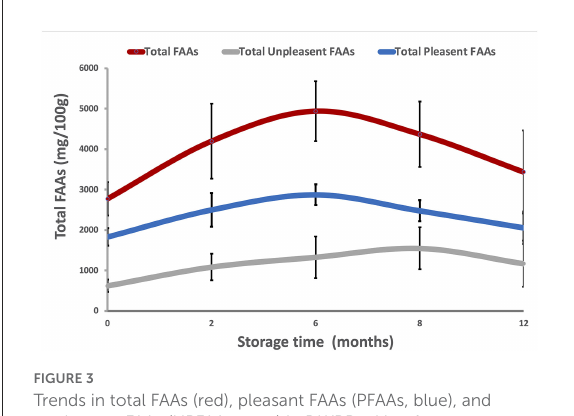
FIGURE3 Trends in total FAAs (red), pleasant FAAs (PFAAs, blue), and unpleasant FAAs (UPFAAs, gray) in DWRP taking frozen storage time into account (12 months at − 18 ◦ C), regardless of the effects of packaging